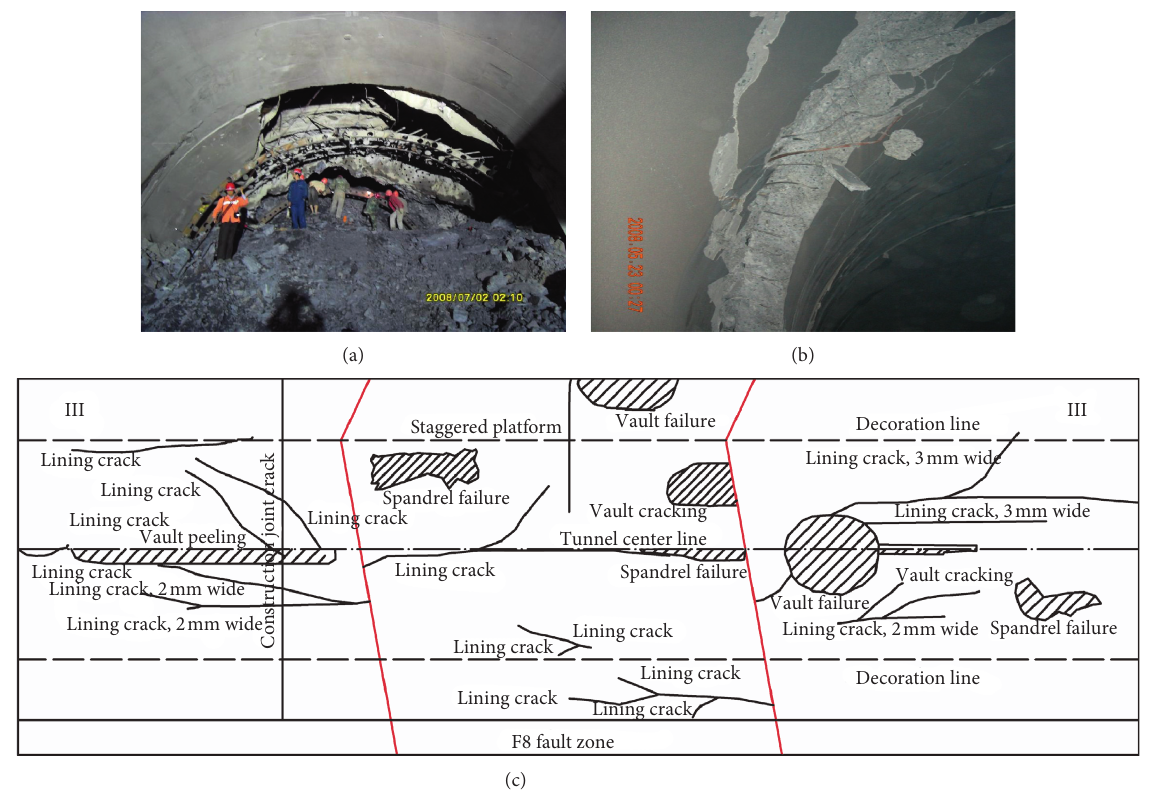
Figure 1: Seismic damage of Longxi Tunnel. (a) Lining collapse. (b) Lining dislocation. (c) Damage near the fault